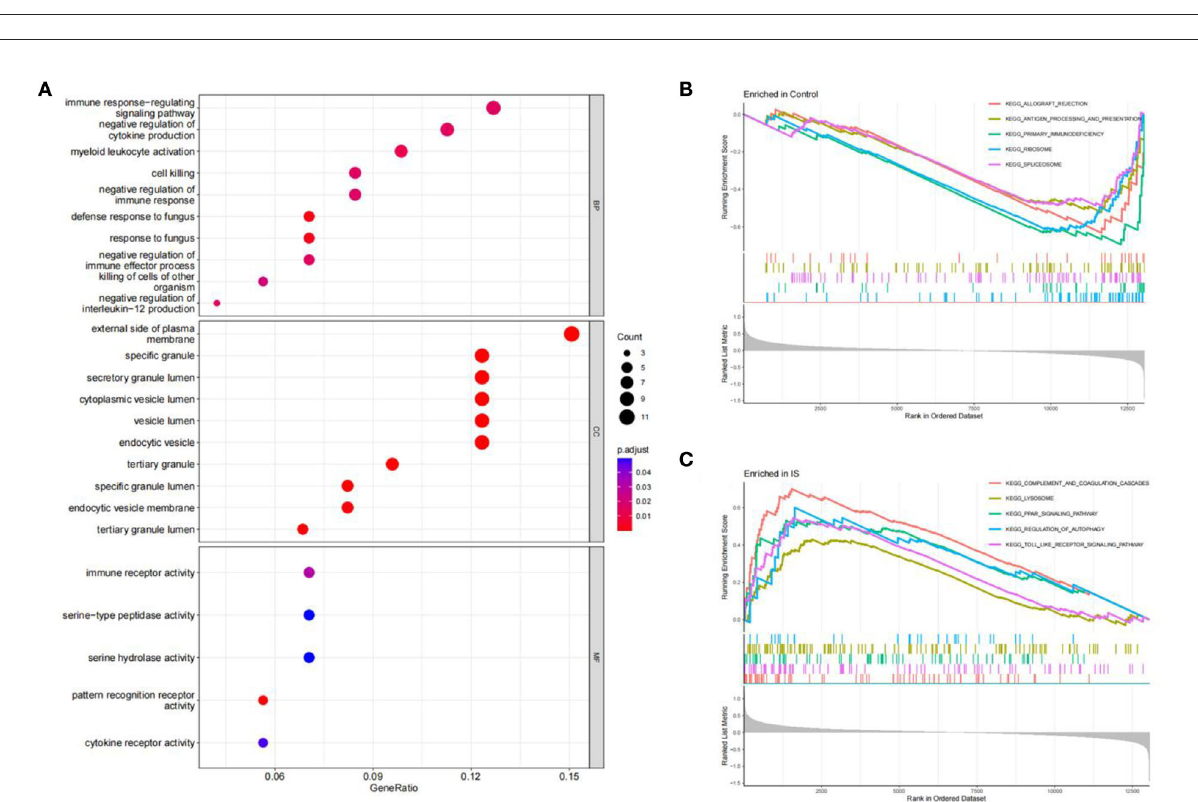
FIGURE3 Function enrichment analysis. (A) GO enrichment analysis of DEGs. The size of the circle indicates the number of genes. The screening criterion was set as adjusted P < 0.05. (B,C) Enrichment plots from GSEA analysis in the control group and IS